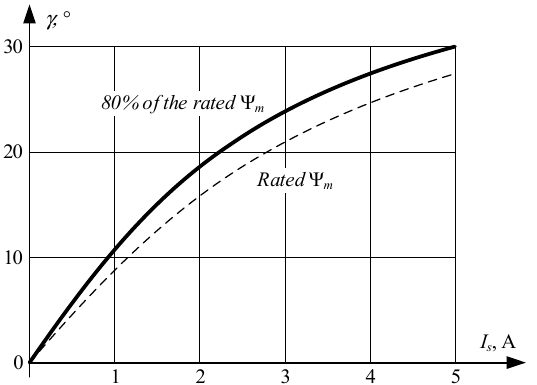
Figure 5. Dependence of the MTPA angles γ on the stator current amplitude at different flux-linkages.